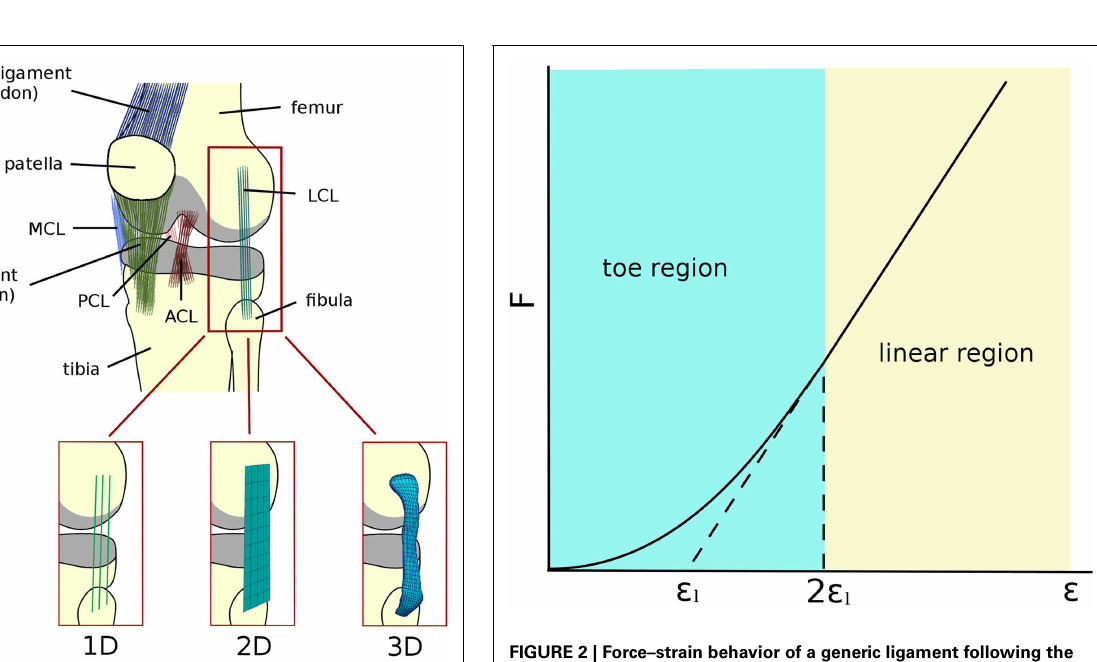
FIGURE 2 | Force–strain behavior of a generic ligament following the model described by Blankevoort et al. (1991a) . 2 ε l is the threshold strain, which indicates the change from the toe to the linear